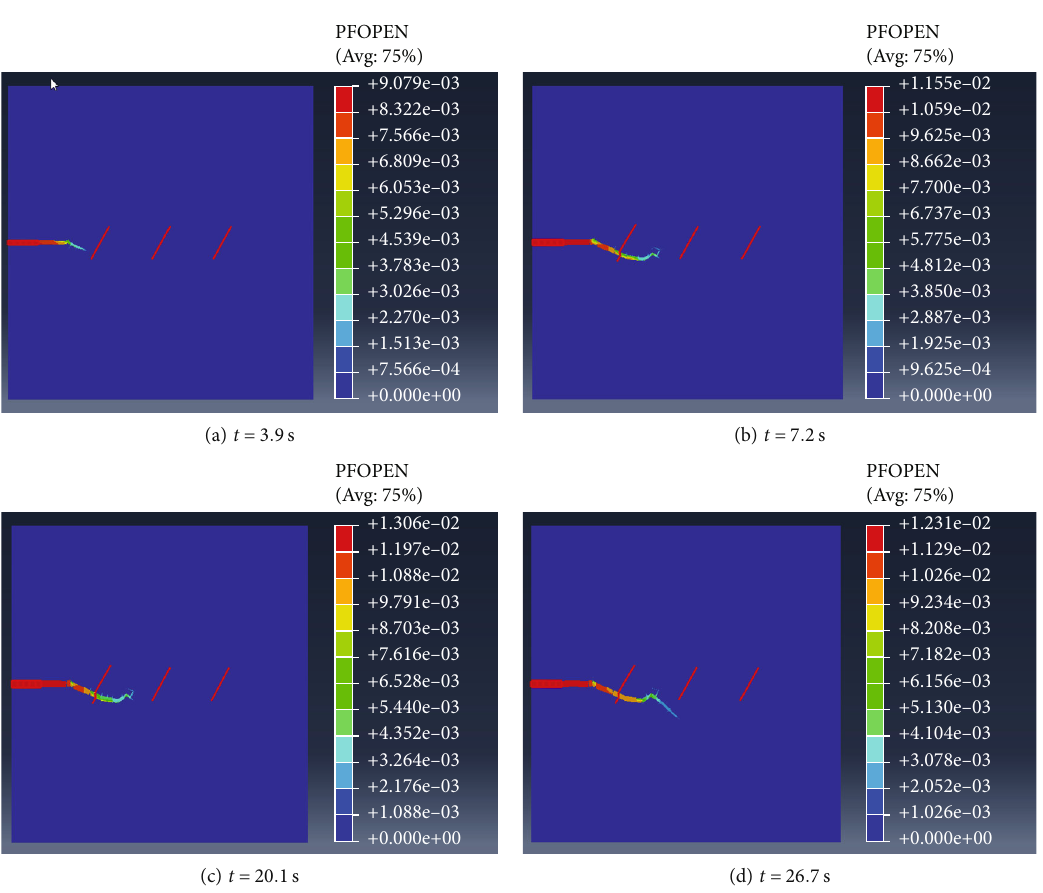
Figure 37: HF propagation at the NF approaching angle of 60 ° and under the stress anisotropy coe ffi cient of 0.1.